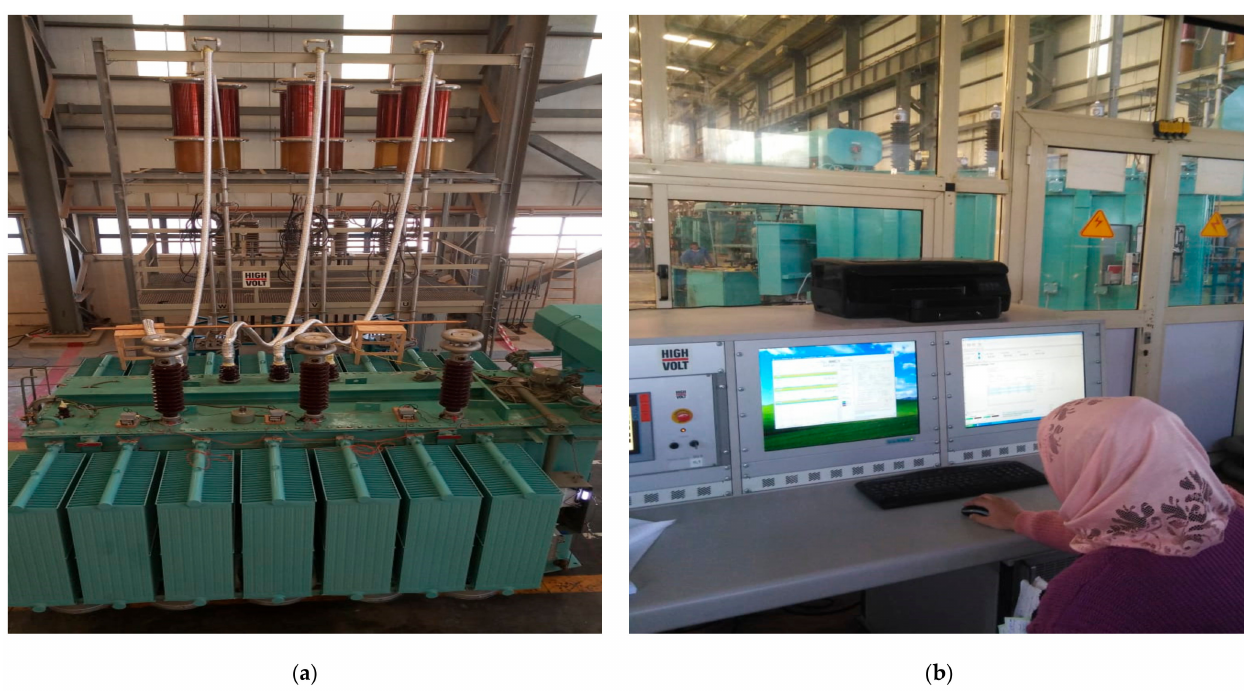
Figure 10. PD measurements; ( a ) power transformer under test, and ( b ) control system for the power transformer.